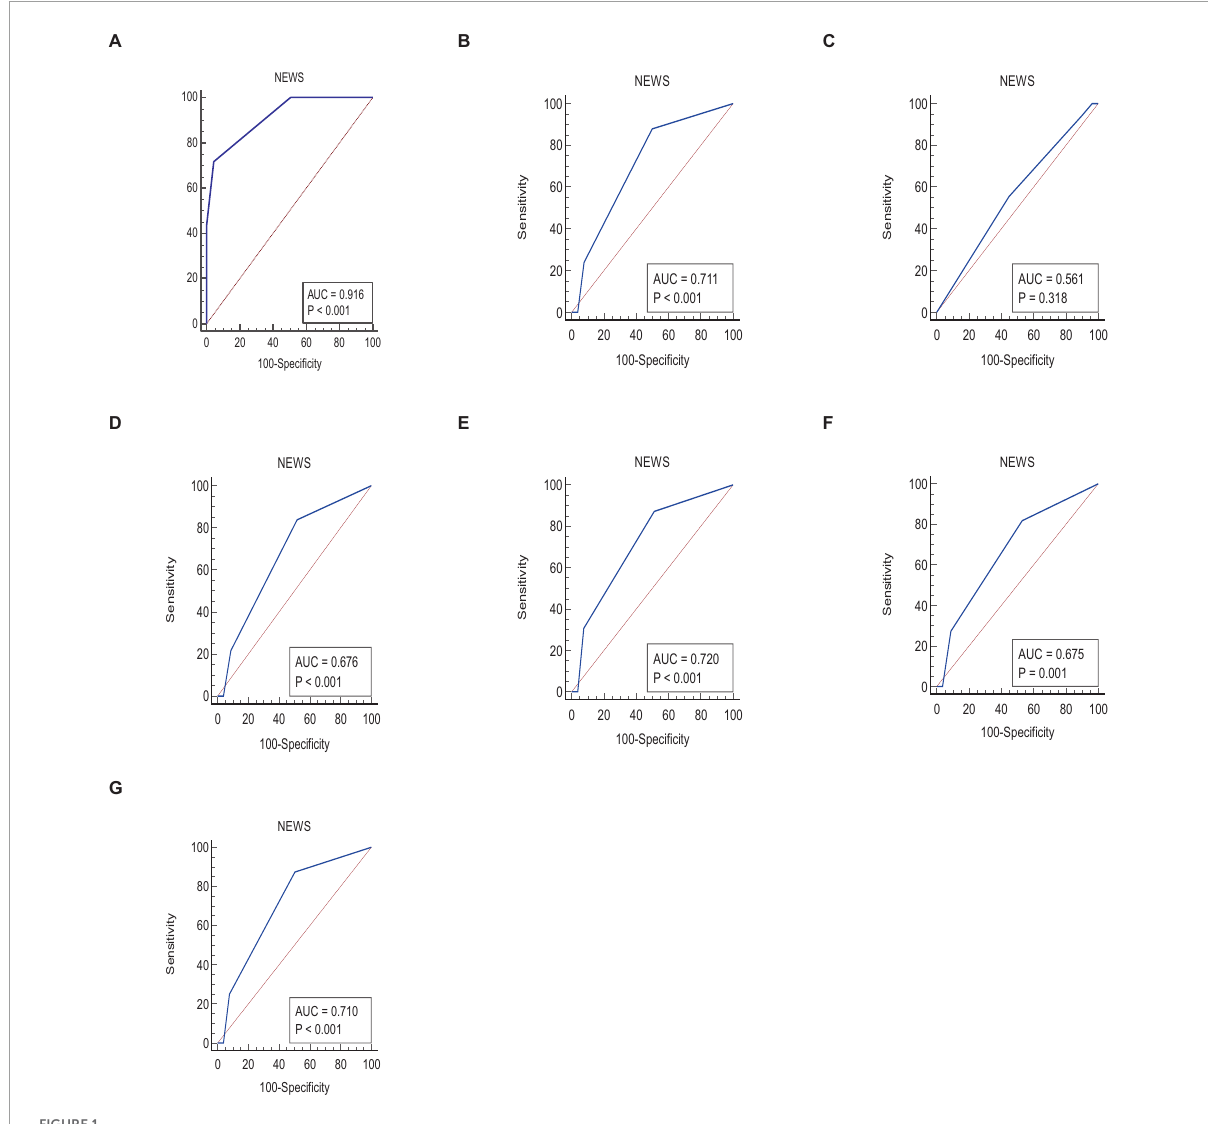
FIGURE1 Comparison of ROC curves between NEWS and MEWS scores to predict (A) mortality, (B) ICU readmission, (C) unplanned discharge type, (D) time to readmission ≥ 4 days, (E) MV after readmission, (F) duration of MV ≥ 6 days, and (G) multiple organ failure after readmission.